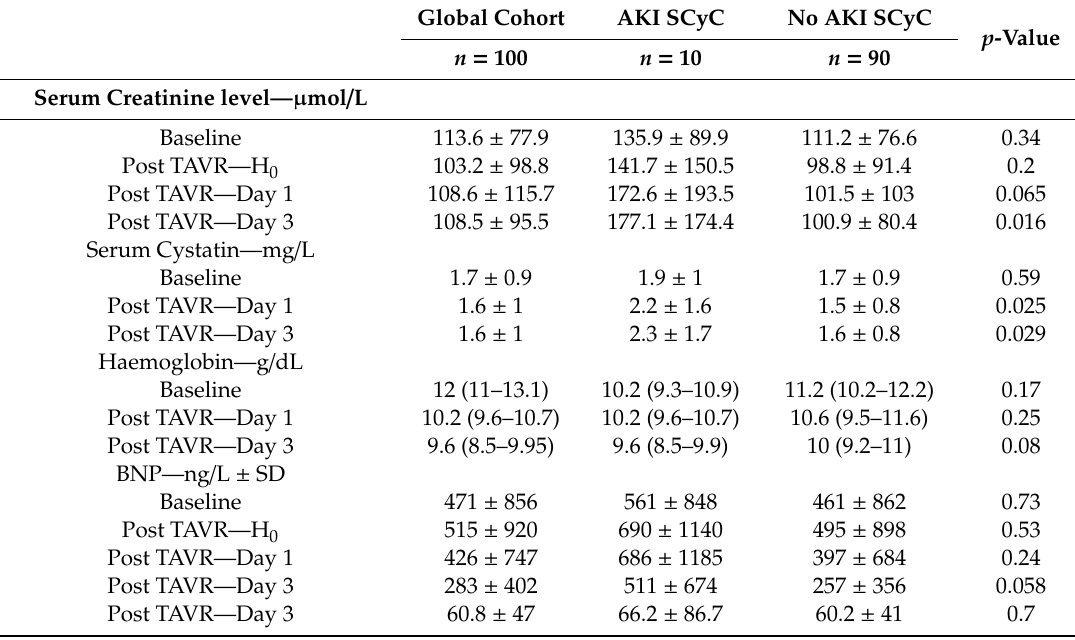
Table 3. Biological parameters.